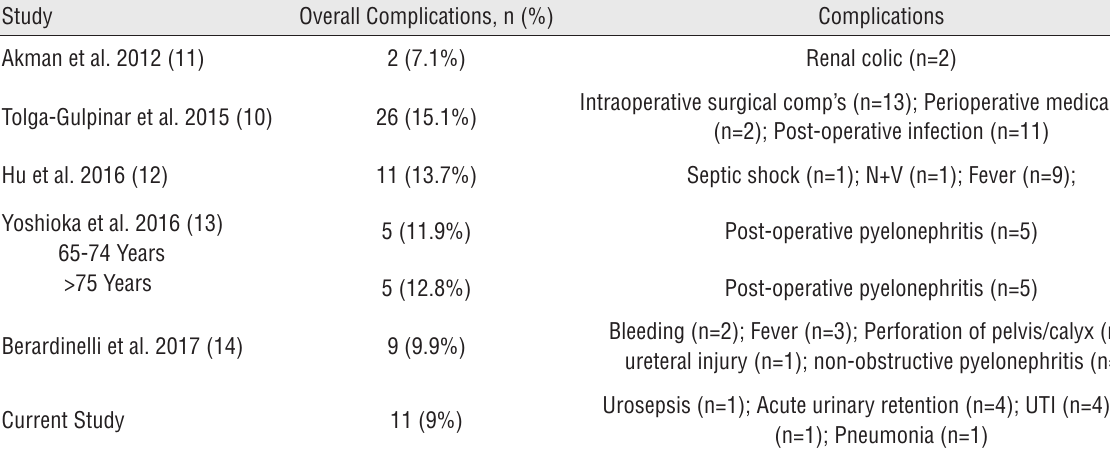
Table 5 - Nature of complications across all